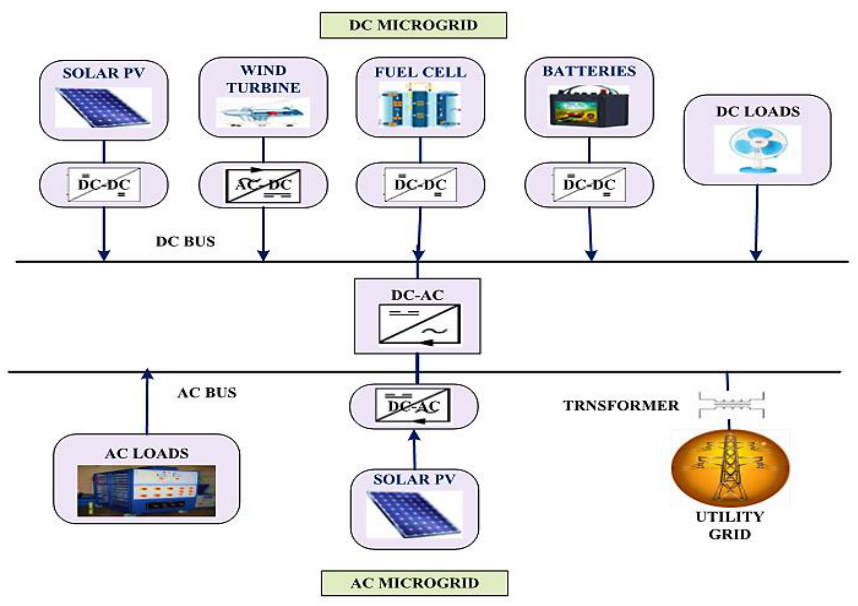
Figure 9. Hybrid AC/DC Microgrid [62].